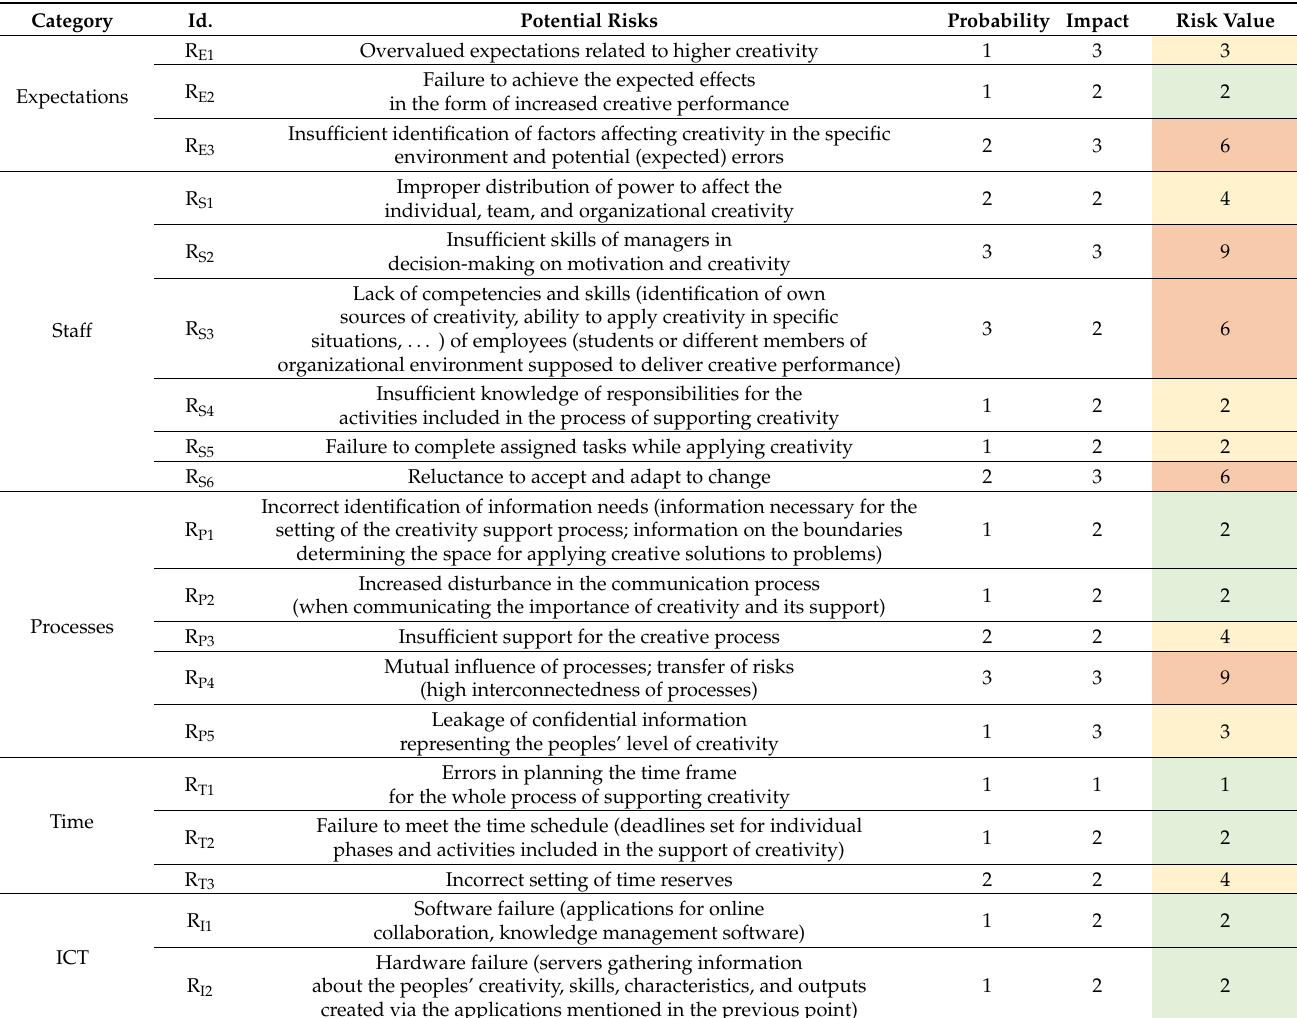
Table 6. Identification of potential risks.